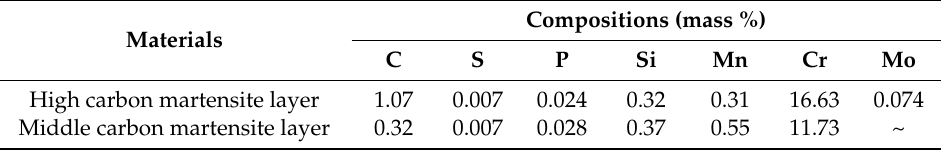
Table 1. Main chemical composition of multilayered steel (mass %).